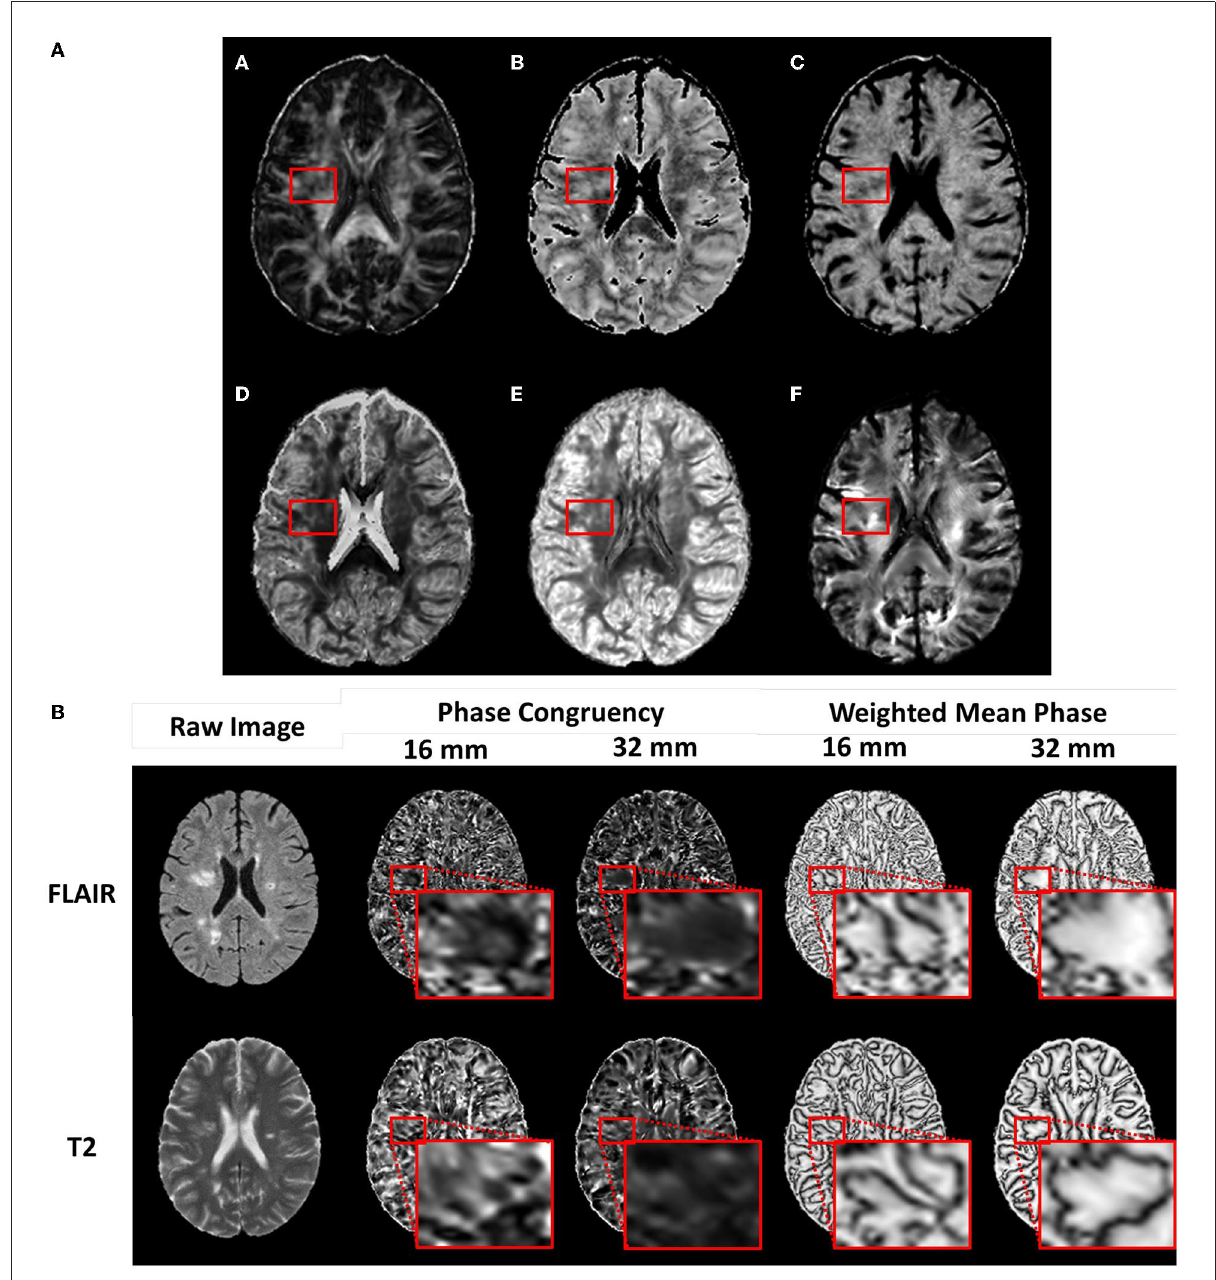
FIGURE1 Example diffusion and phase congruency texture maps. (A) Diffusion MRI of a) fractional anisotropy, b) axonal diameter, c) intracellular volume fraction, d) Orientation Dispersion Index, e) Orientation Distribution Function energy f) Apparent Fiber Density, and (B) phase congruency of (top row) FLAIR MRI and (bottom row) T2